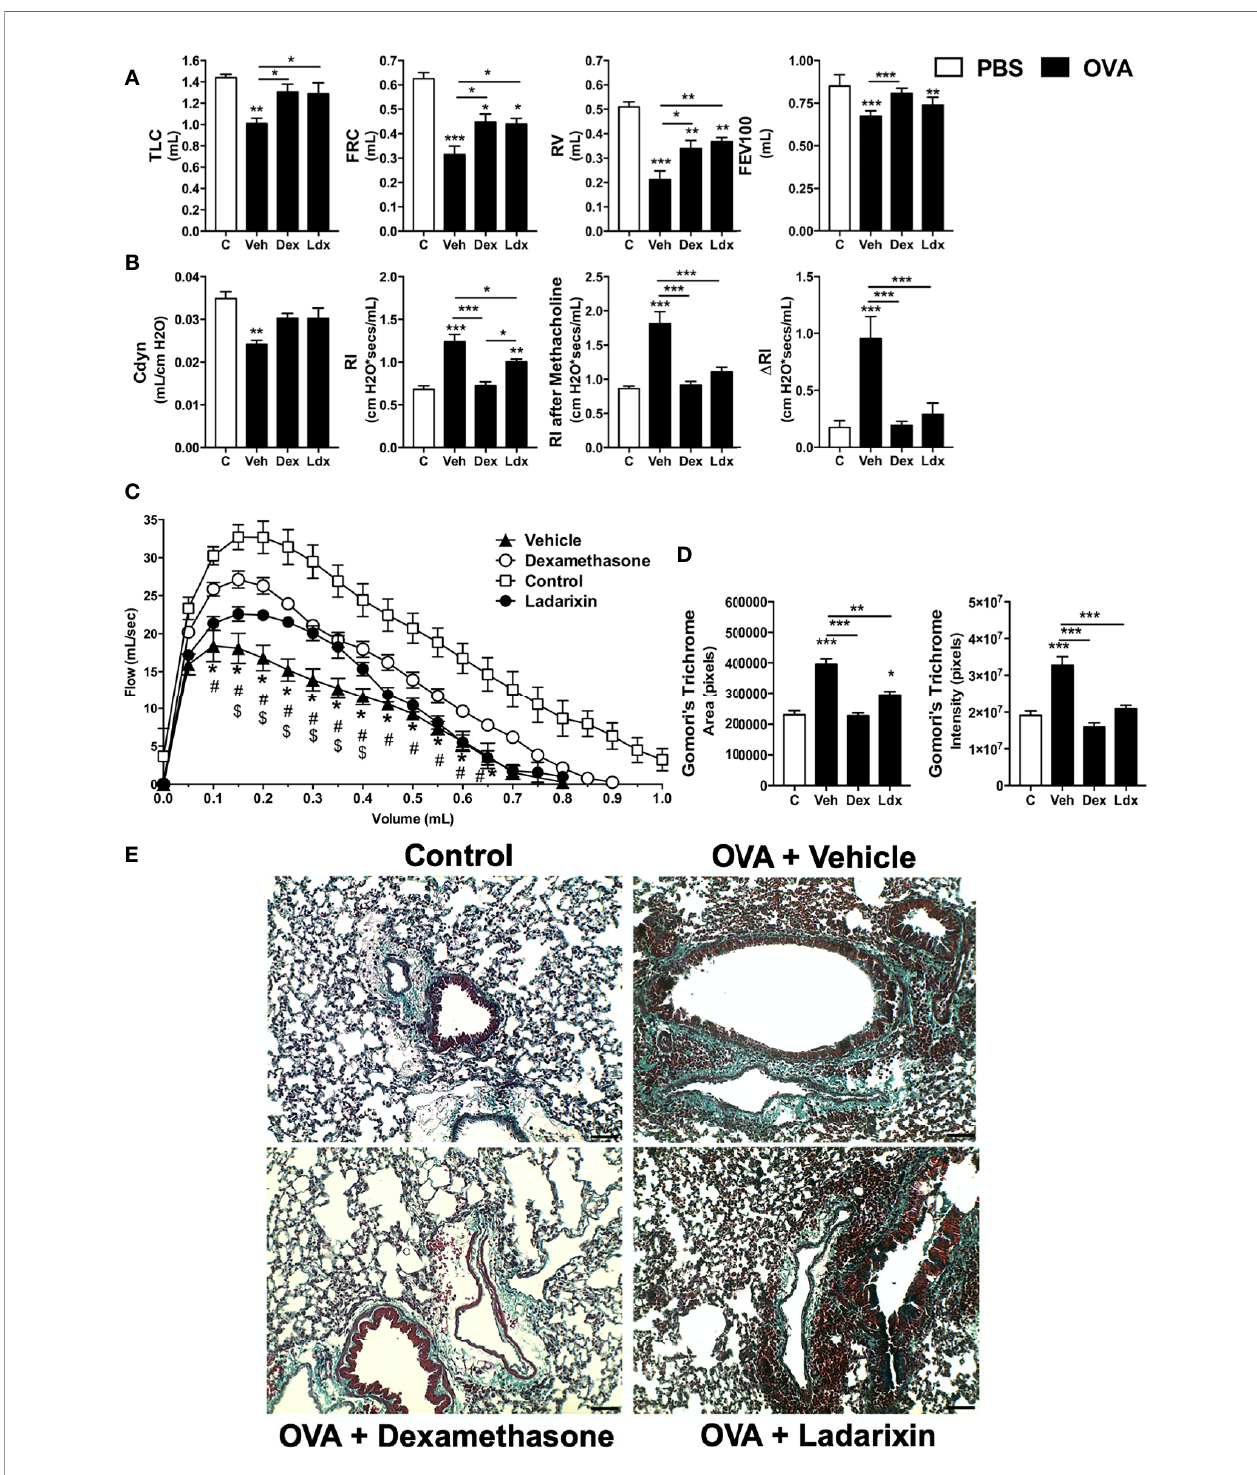
FIGURE 6 | Ladarixin treatment decreases fi brosis and improves pulmonary function in chronic asthma model. In fl ammatory parameters were evaluated after 8 OVA challenges given every other day. Lung fi brosis, as assessed by Gomori ’ s trichrome staining, and functional parameters were evaluated 24 h after the last challenge. Mice were treated with Ladarixin (10 mg/kg, gavage) or dexamethasone (5 mg/kg, s.c.) as indicated in . Pulmonary mechanics were assessed for (A) lung volumes, (B) compliance and lung resistance. (C) Flow-Volume curve. (D) fi brosis score. (E) Histological sections of lungs (Gomori ’ s trichrome dye). n = 8 for each group, * for P < 0.05; ** for P < 0.01 and *** for p < 0.001. TLC, total lung capacity; RV, residual volume; FRC, functional residual capacity; FEV100, forced expiratory volume in 100 ms; Cdyn, dynamic compliance; Rl, lung resistance; D Rl, methacholine-evoked hyperresponsiveness. # differences between Dexamethasone vs Vehicle. $ differences between Ladarixin vs